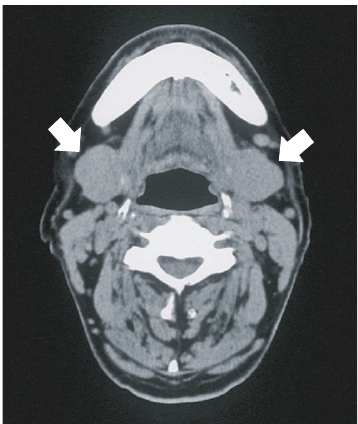
Figure 1: Cervical CT images of Case 1. Bilateral swelling of the submandibular glands